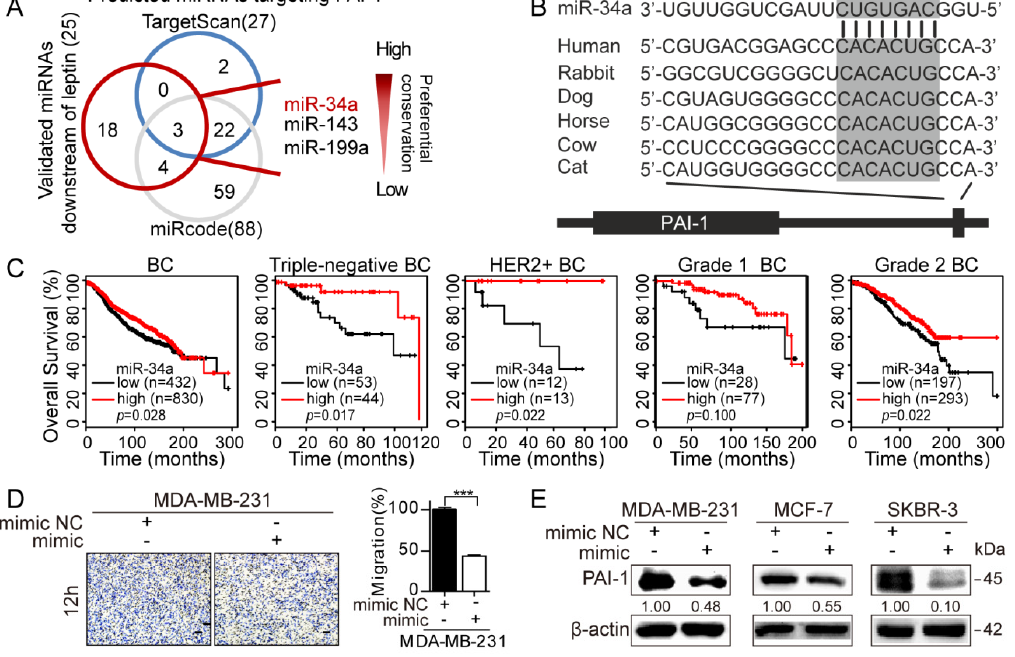
Figure 7. Leptin/OBR induces PAI-1 expression by repressing miR-34a. ( A ) Prediction of miRNAs targeting PAI-1. A total of 25 potential PAI-1-targeting miRNAs were simultaneously predicted by TargetScan and miRcode databases. ( B ) Conservative binding site for miR-34a at the 3 ′ UTR of PAI-1. ( C ) Prognostic value of miR-34a in patients with different types or grades of breast cancer by KM plotter analysis. ( D ) Transwell migration assays of MDA-MB-231cells after transfection with the miR- 34a mimic (100 nM, 48 h). Scale bar: 100 μ m. ( E ) Breast cancer cells transfected with the miR-34a mimic (100 nM, 48 h) were collected for western blot analysis. ( F ) qRT-PCR. OBR was depleted in breast cancer cells with siRNA followed by adipocyte coculture for 72 h, andthen miR-34a expression was detected. ( G ) Expression of miR-34a was measured in breast cancer cells by qRT-PCR after transfection with the miR-34a mimic (100 nM, 48 h) and treatment with leptin (100 ng/mL, 24 h). ( H ) Breast cancer cells transfected with OBR-specific siRNA were collected for qRT-PCR to detect miR- 34a expression. ( I ) After transfection with the miR-34a mimic (100 nM, 48 h), breast cancer cells were further treated with leptin (100 ng/mL, 24 h), and then the PAI-1 levels were examined by western blot. The results are presented as the mean ± SEMs from three independent experiments, * p < 0.05, ** p < 0.01, *** p < 0.001.